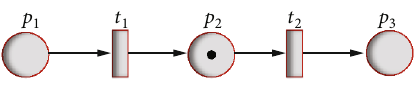
Figure 1: Sequential relationship of an SPN model.